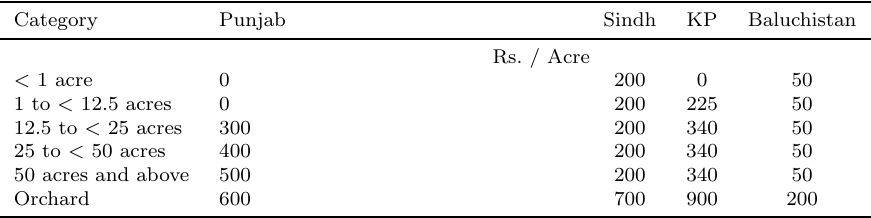
Table 2: Provincial land-based tax